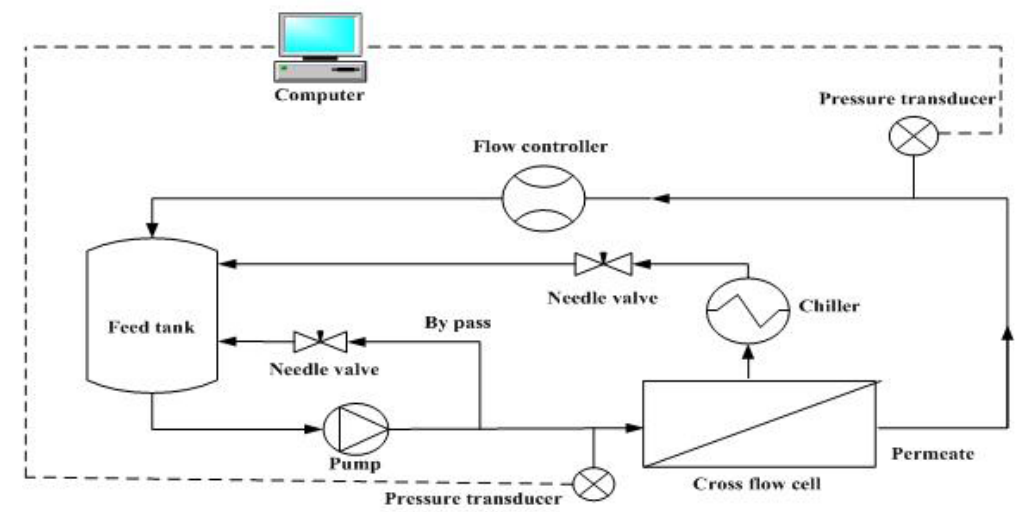
Figure 1. Schematic illustration of the experimental set up.